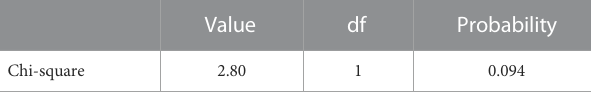
TABLE4Cointegrationtestresults(CointegrationTest — ParkAddedVariables).